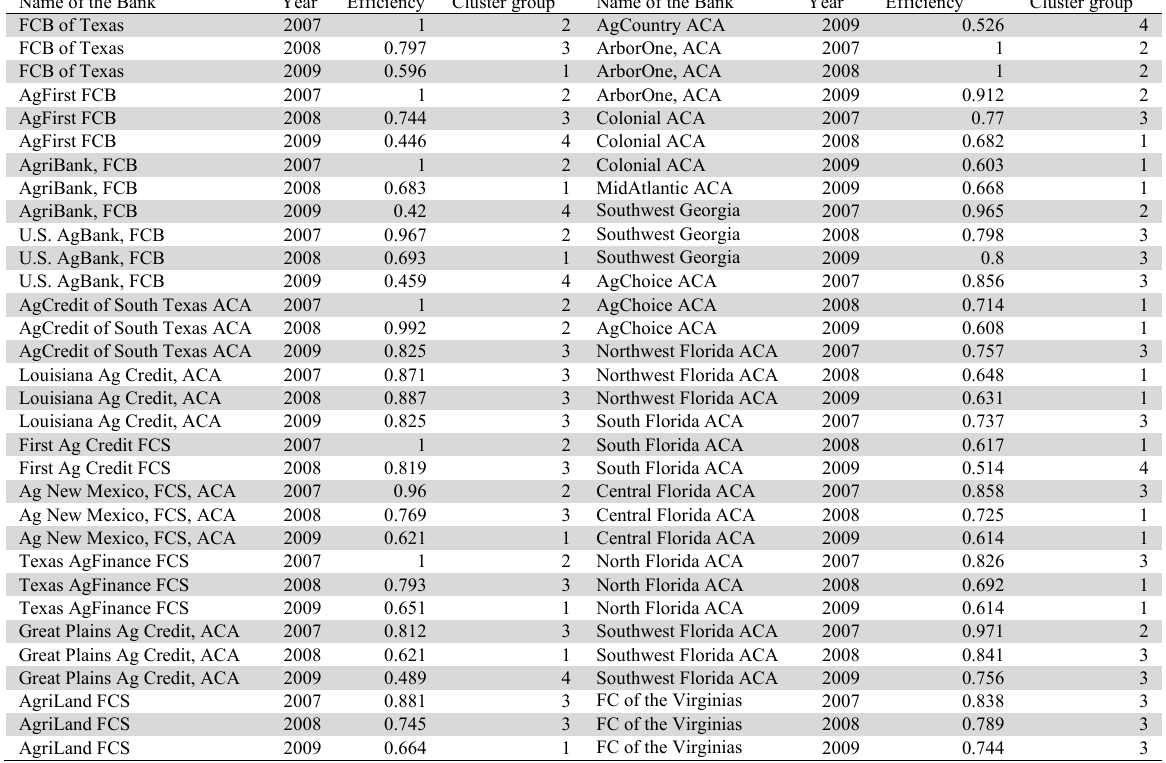
Efficiency Measure